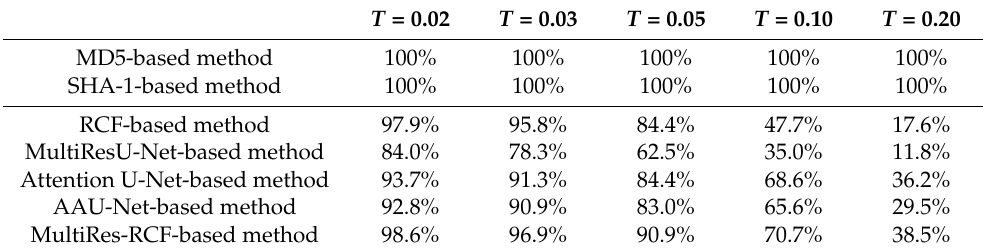
Table 7. Tamper detection rate after 8 × 8 pixel tampering area is modified.